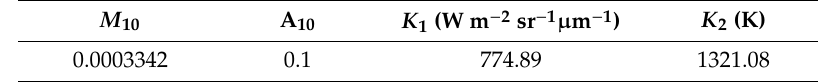
Table 3. Parameters for computing at-sensor brightness temperature from Landsat 8 TIRS band 10